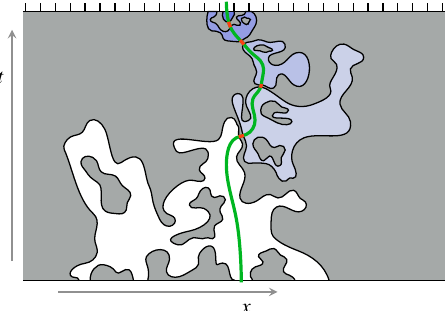
FIG. 8. Cartoon for the scaling argument showing S 0 ð t Þ ∼ log t at the percolation critical point (cf. Figs. 6 and 7). The minimal cut passes through the sequence of white domains shown in blue and white. Writing the linear sizes of consecutive domains in this =R sequence as R 1 ; R 2 ; … , the ratio R is typically larger than 1 i þ 1 i (see text), so for an i of order log t , the minimal cut reaches a cluster of O ð t Þ size that borders the boundary and the sequence ends. Domains i and i þ 1 typically approach each other to within one lattice spacing, so the cost scales as the number of domains in the sequence.